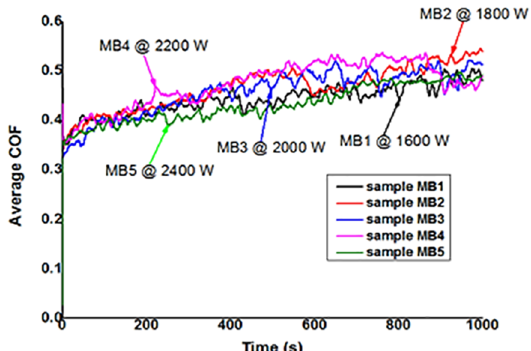
Figure 10. COF of laser deposited samples at different laser powers.